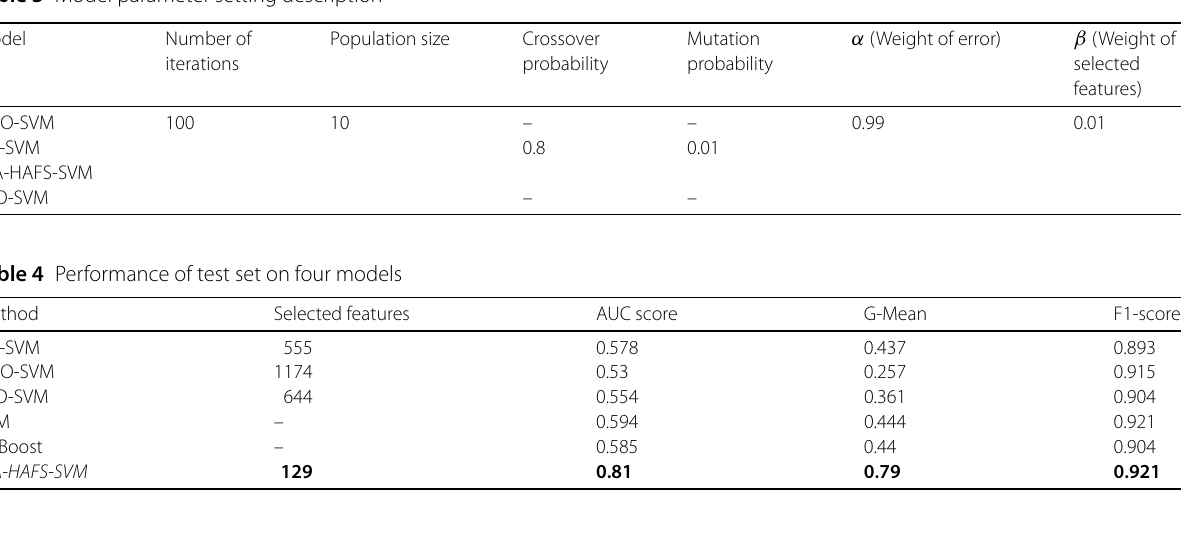
Table 3 Model parameter setting description